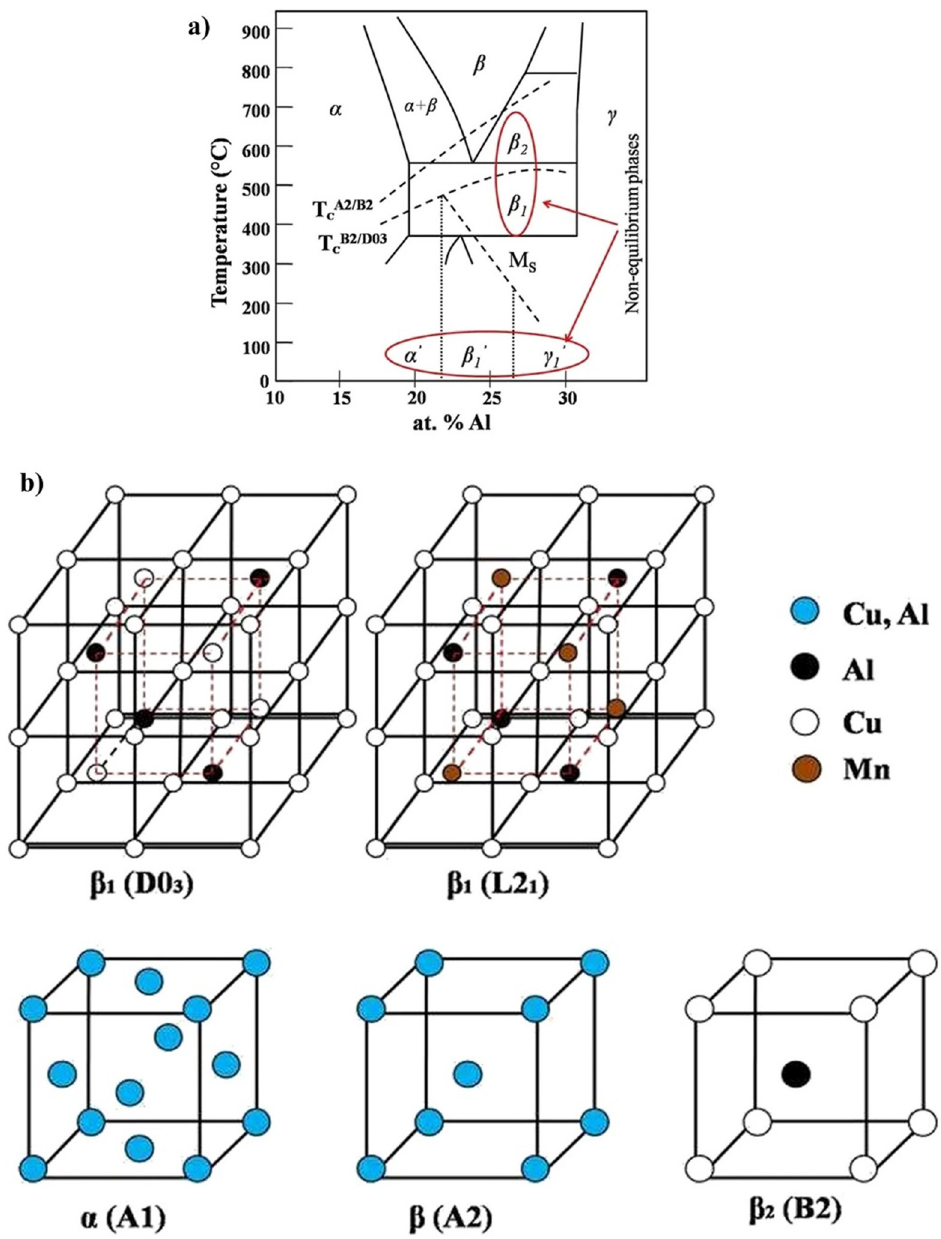
Figure 1: ( a ) Cu – Al binary phase diagram and ( b ) the crystal structure of di ff erent phases [ 23 ]